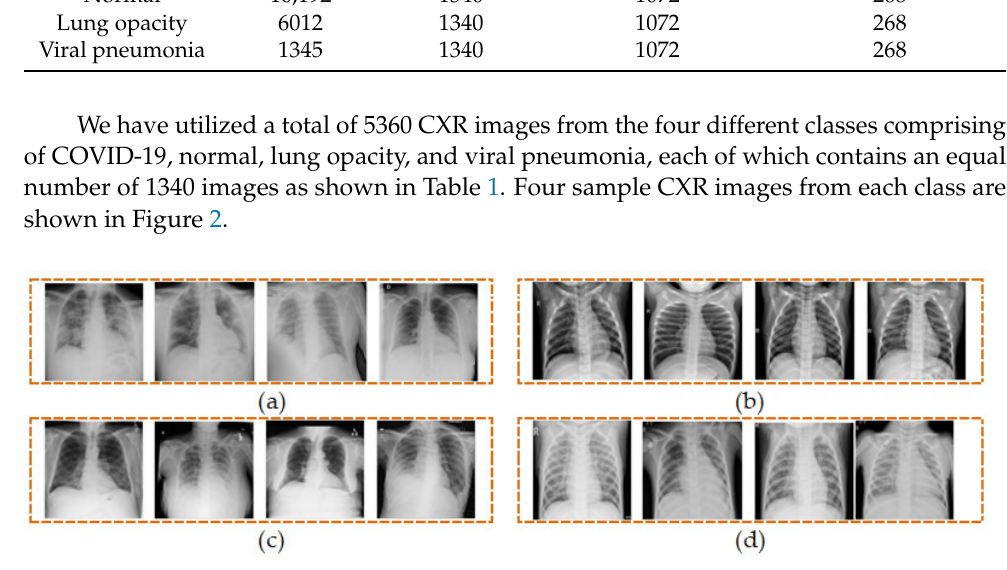
Figure 2. Samples of CXR images from four classes of ( a ) COVID ‐ 19, ( b ) normal, ( c ) lung opacity, and ( d ) viral pneumonia.